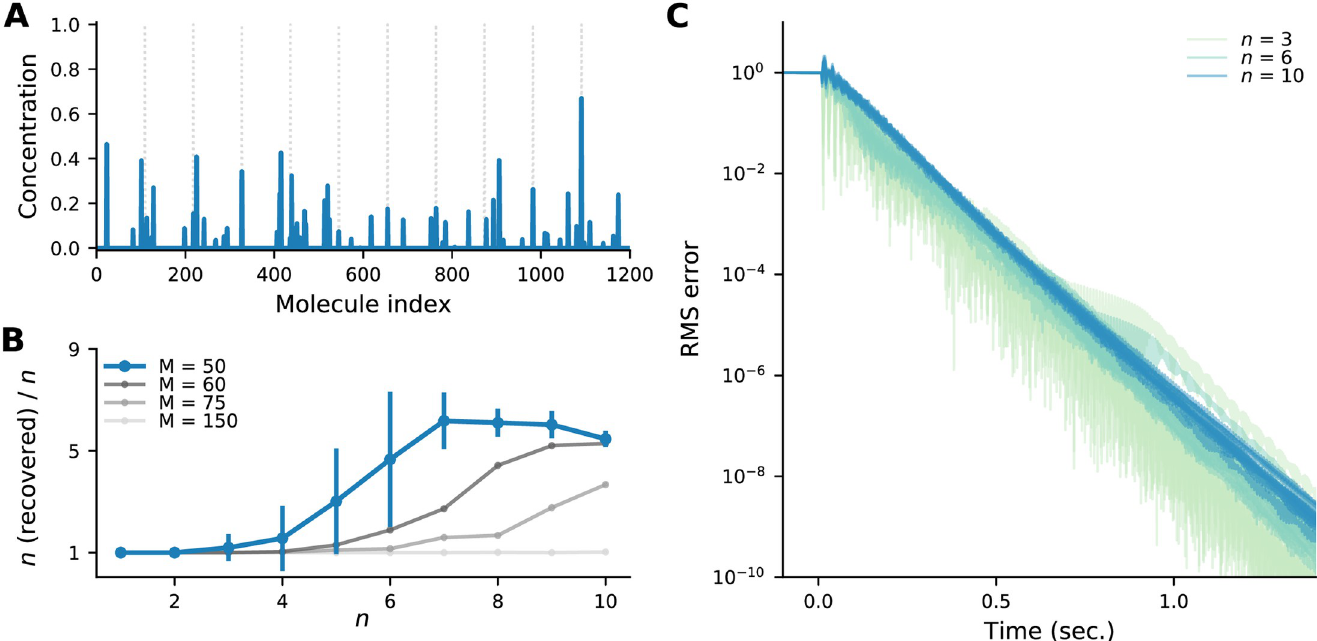
Fig 11. The effect of the number of odour components, n , on inference. (A) The MAP estimate for an odour with n = 10 components contains many more than 10 non-zero values. (B) Ratio of the number of odour components inferred using MAP inference to the true number, versus the true number of odour components, n for different numbers of glomeruli, M . An odour component was considered inferred when granule cell activation was greater than 10 − 2 . Dots are averages over 12 trials, vertical lines are standard deviations (shown only for M = 50 for clarity). When using the default number of glomeruli, M = 50, extra odour components are inferred when n is above about 3. Adding glomeruli, however, allows more odours to be correctly inferred. (C) Time course of the RMS error between the granule cell activations and the MAP estimate, for 6 different trials at each n . Parameters from Table 1, except S = 8, and M = 50 unless indicated otherwise.